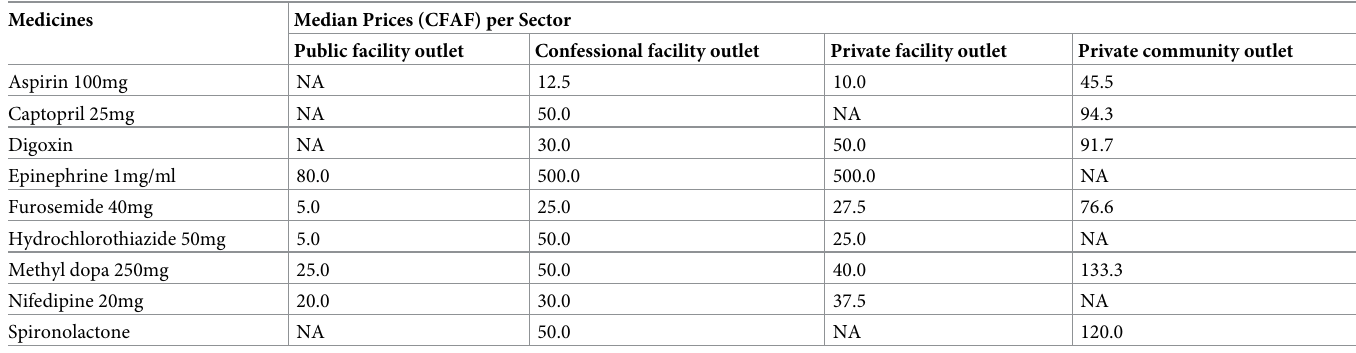
Table 4. Median prices across sectors for some selected medicines.